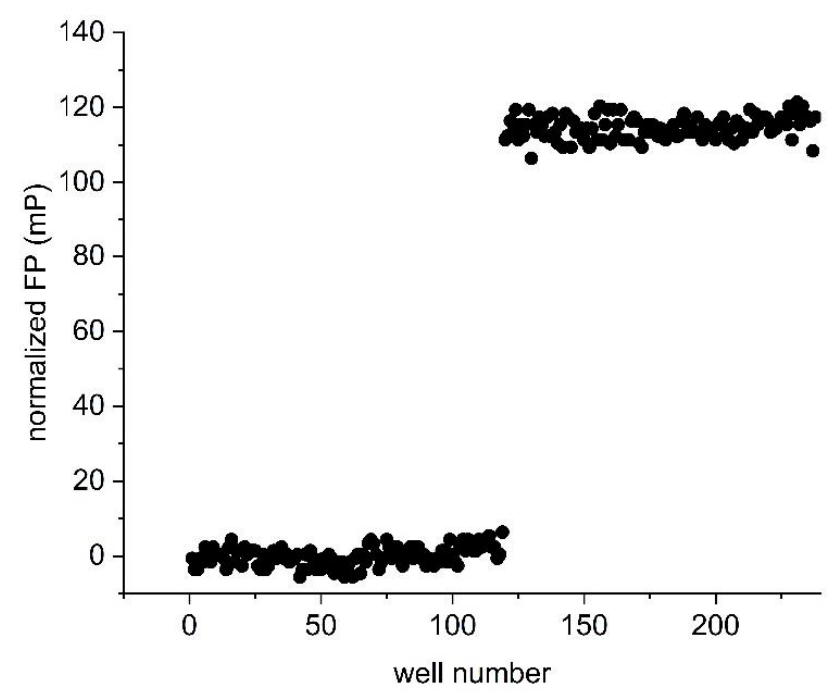
Figure 5. Determination of the Z’ value. Fluorescence polarization was measured in samples containing 10 nM 5-CF-GpYLPQNID in the absence (wells 1–119) and presence (wells 120–238) of 33 nM STAT4. The data were normalized by subtracting the average FP reading of the peptide-only wells from all well FP values. The Z’ value of the representative experiment shown is 0.86.